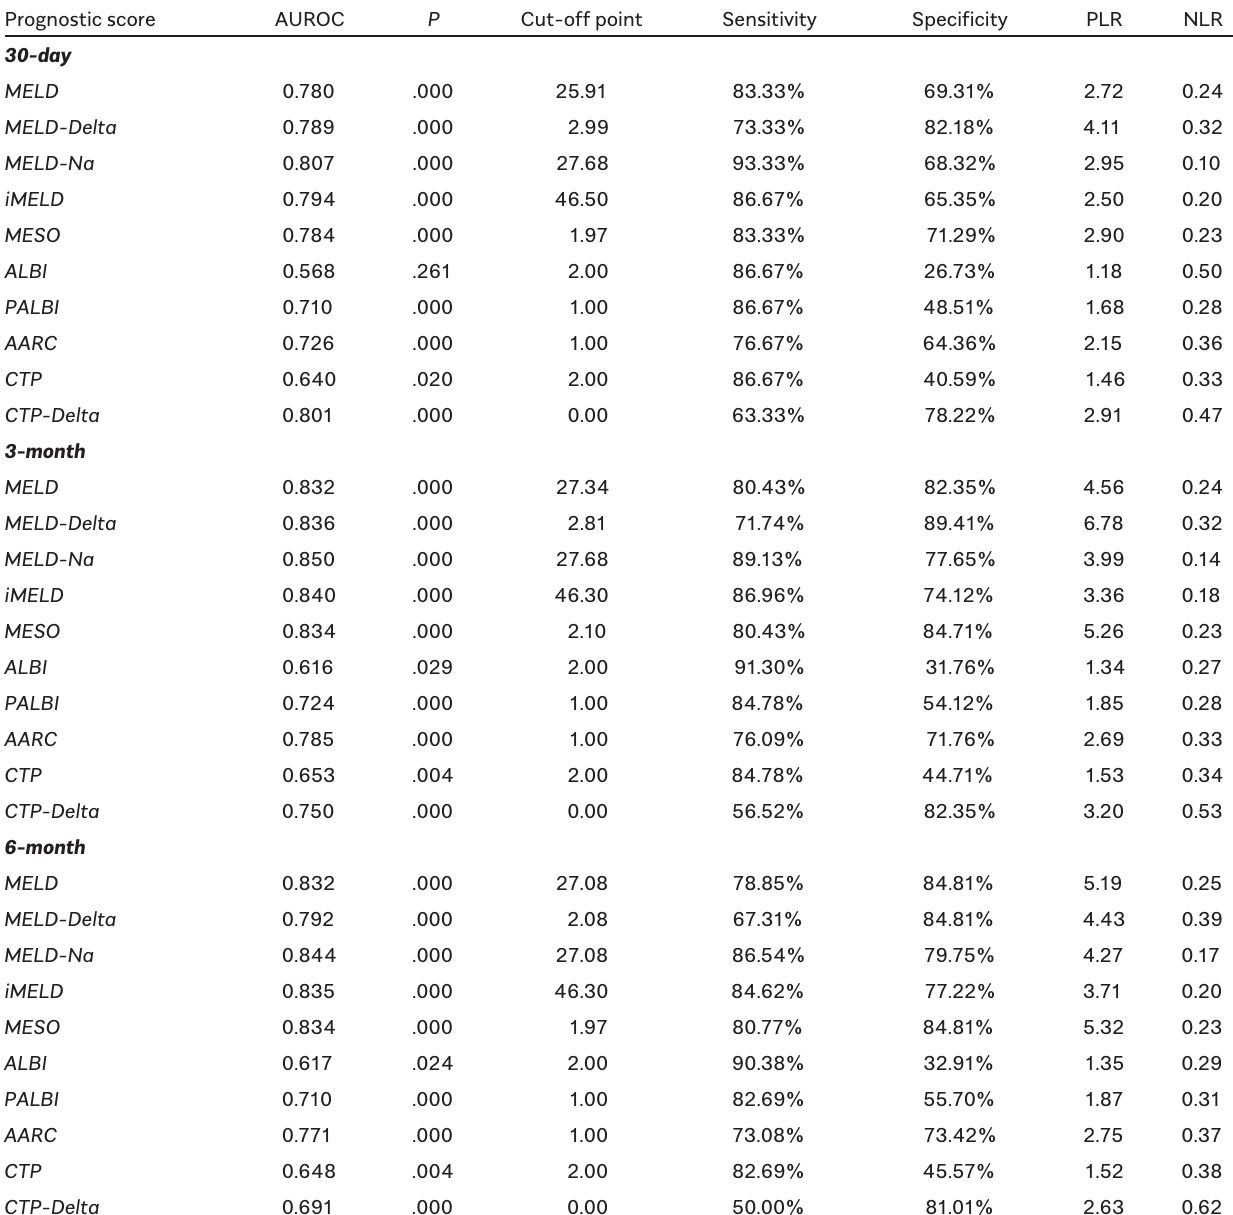
Table 3. Accuracy of Different Scoring Systems in Predicting the Survival of Patients Prognostic